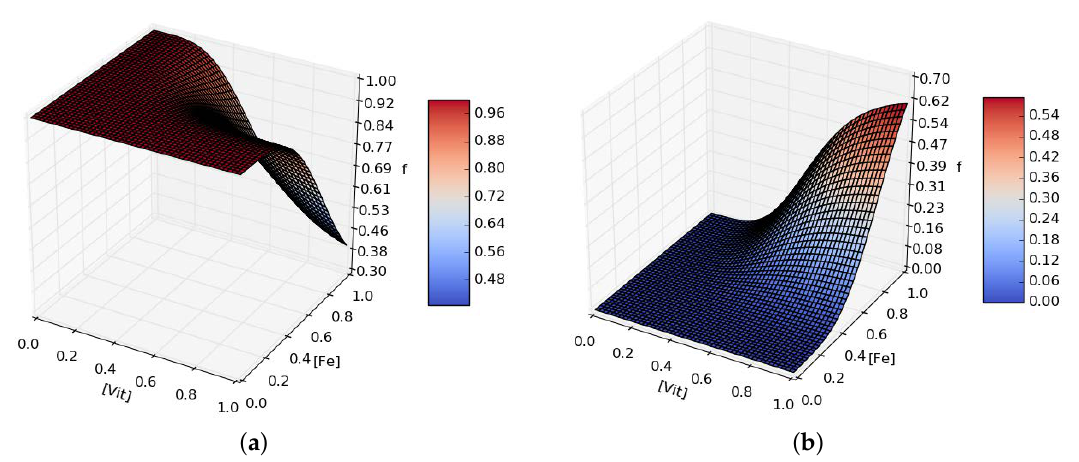
Figure A2. Example for DOC A (( a ), 1 − ξ ) and COP (( b ), ξ ) additional production rates dependent on Vit and Fe availability in the media. Here K (cid:48) D